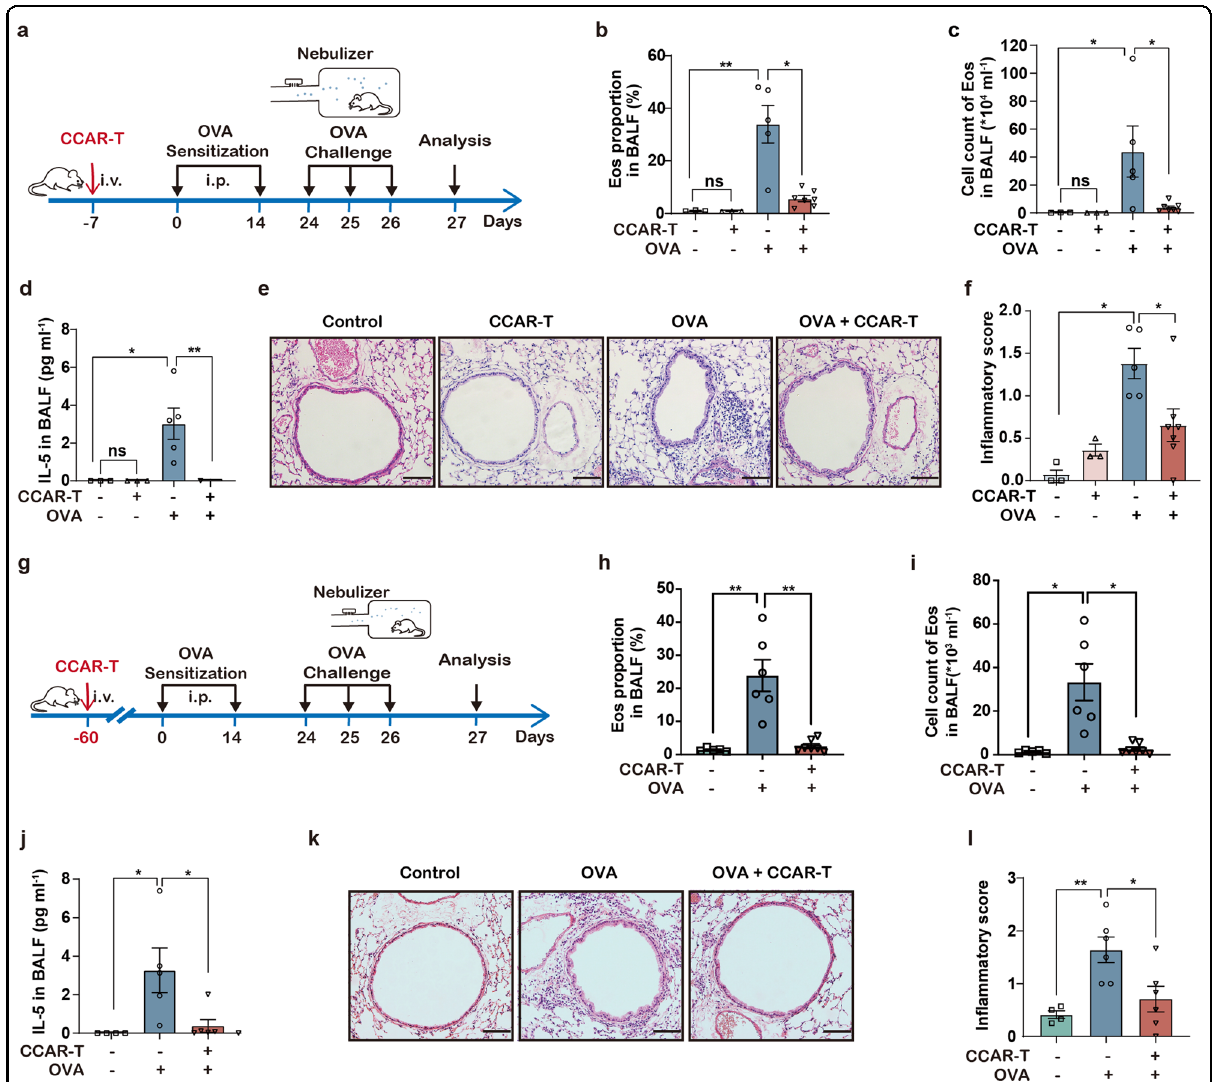
Fig. 5 IL-5-anchored CCAR-T cells exhibit durable asthma control. a Timeline of intravenous injection of mIL-5-anchored CCAR-T cells, OVA- aerosol administration for the asthma model, and sample analysis in BALB/c mice. b Flow cytometry analysis of Eos proportion in BALF. * P < 0.05, ** P < 0.01 by two-tailed Welch ’ s t -test. c Cell count of Eos in BALF in OVA-induced asthma model. * P < 0.05 by two-tailed Mann-Whitney test. d The concentration of IL-5 cytokine in BALF was determined by CBA. * P < 0.05, ** P < 0.01 by two-tailed Mann-Whitney test. e Representative images of the pulmonary sections stained with H&E. Scale bars, 100 μ m. f In fl ammation scores of the H&E-stained sections determined by semi-quanti fi cation. * P < 0.05 by two-tailed Mann-Whitney test. g Timeline of CCAR-T cell administration and sample analysis in the allergic airway in fl ammation model. h Flow cytometry analysis of Eos proportion in BALF. ** P < 0.01 by two-tailed Mann-Whitney test. i Cell count of Eos in BALF. * P < 0.05 by two-tailed Mann-Whitney test. j The secretion of IL-5 cytokine in BALF was determined by CBA. CBA, Cytometric Bead Array. Two-tailed Mann-Whitney test, * P < 0.05. k Representative images of the pulmonary sections stained with H&E. Scale bars, 100 μ m. l In fl ammation scores of the H&E-stained sections determined by semi-quanti fi cation. * P < 0.05, ** P < 0.01 by two-tailed Welch ’ s t